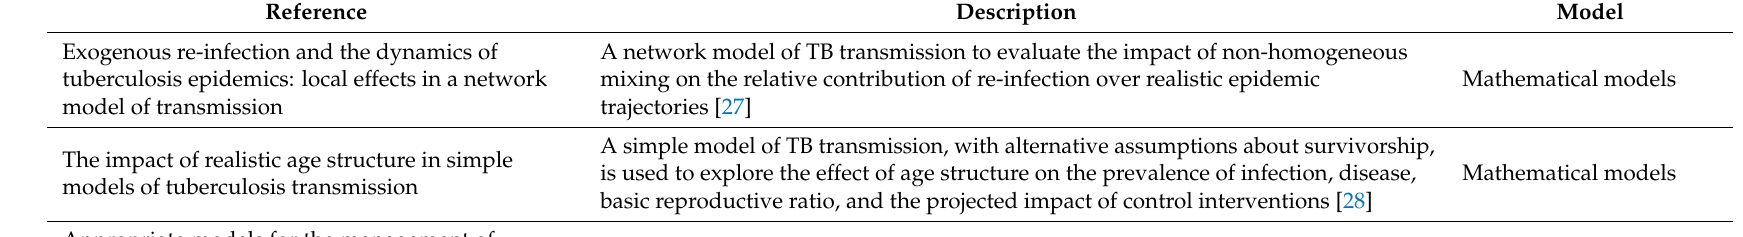
Table 1. The different forecasting approaches of tuberculosis